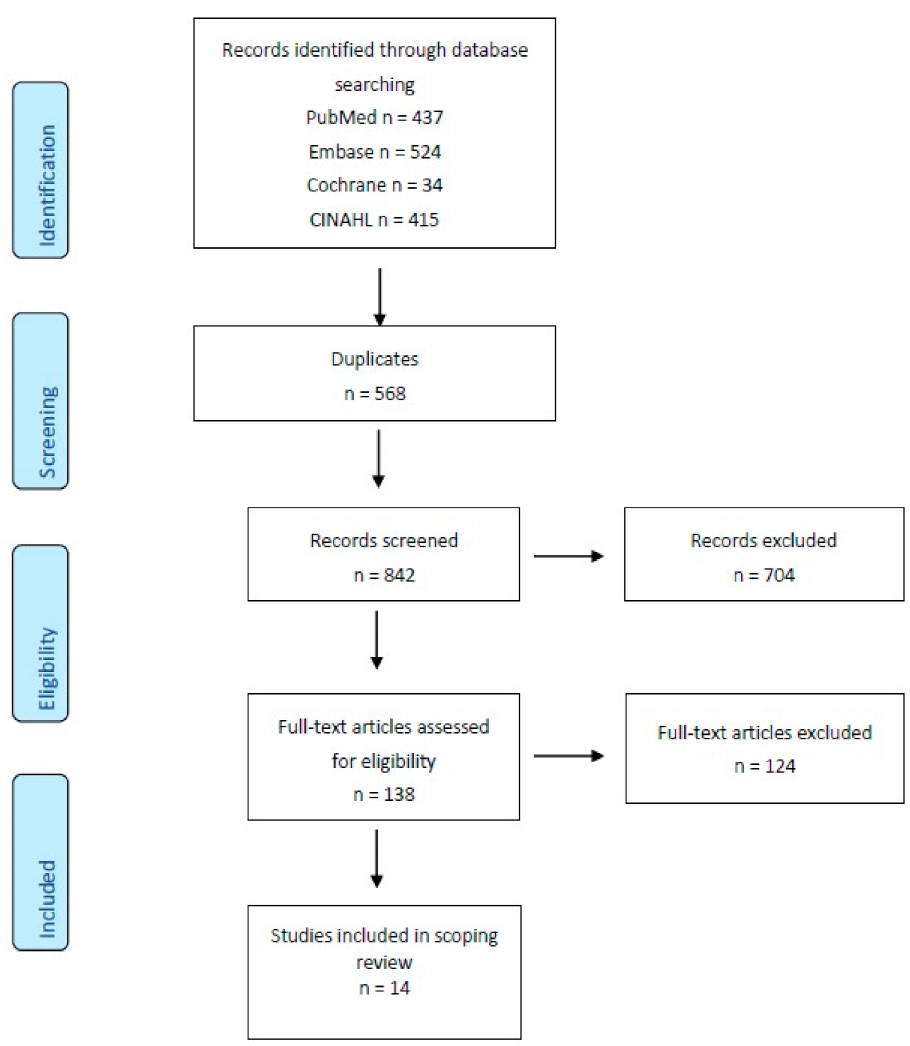
Figure 2. PRISMA flow diagram for scoping reviews, adapted from Tricco et al. [27]. The included studies took place in the United States ( n = 6), Taiwan ( n = 2), Canada ( n = 1), the Netherlands ( n = 1), Japan ( n = 1), Korea ( n = 1), Italy ( n = 1), and Belgium ( n =